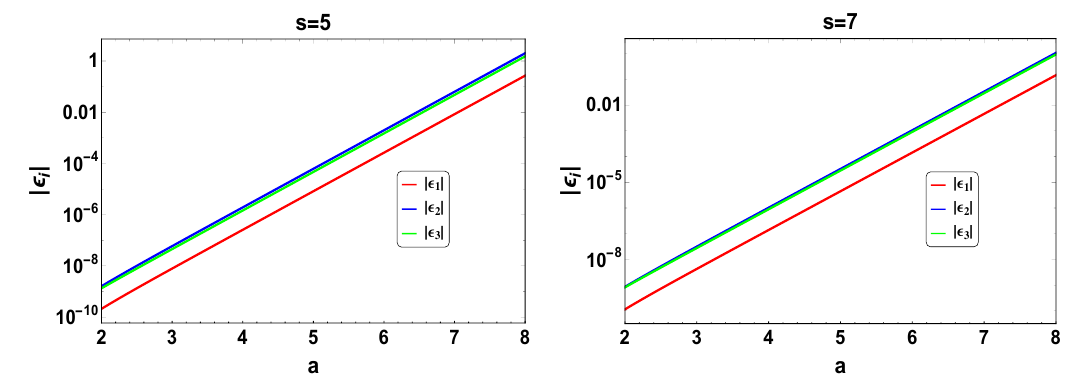
Figure 10 . Order of lepton asymmetry parameter (cid:15) i as a function of a in eq. (6.2) for considering scalar masses M φ = { 10 5 , 10 5 . 1 , 10 5 . 2 } GeV (left) and M φ i benchmark point I in table